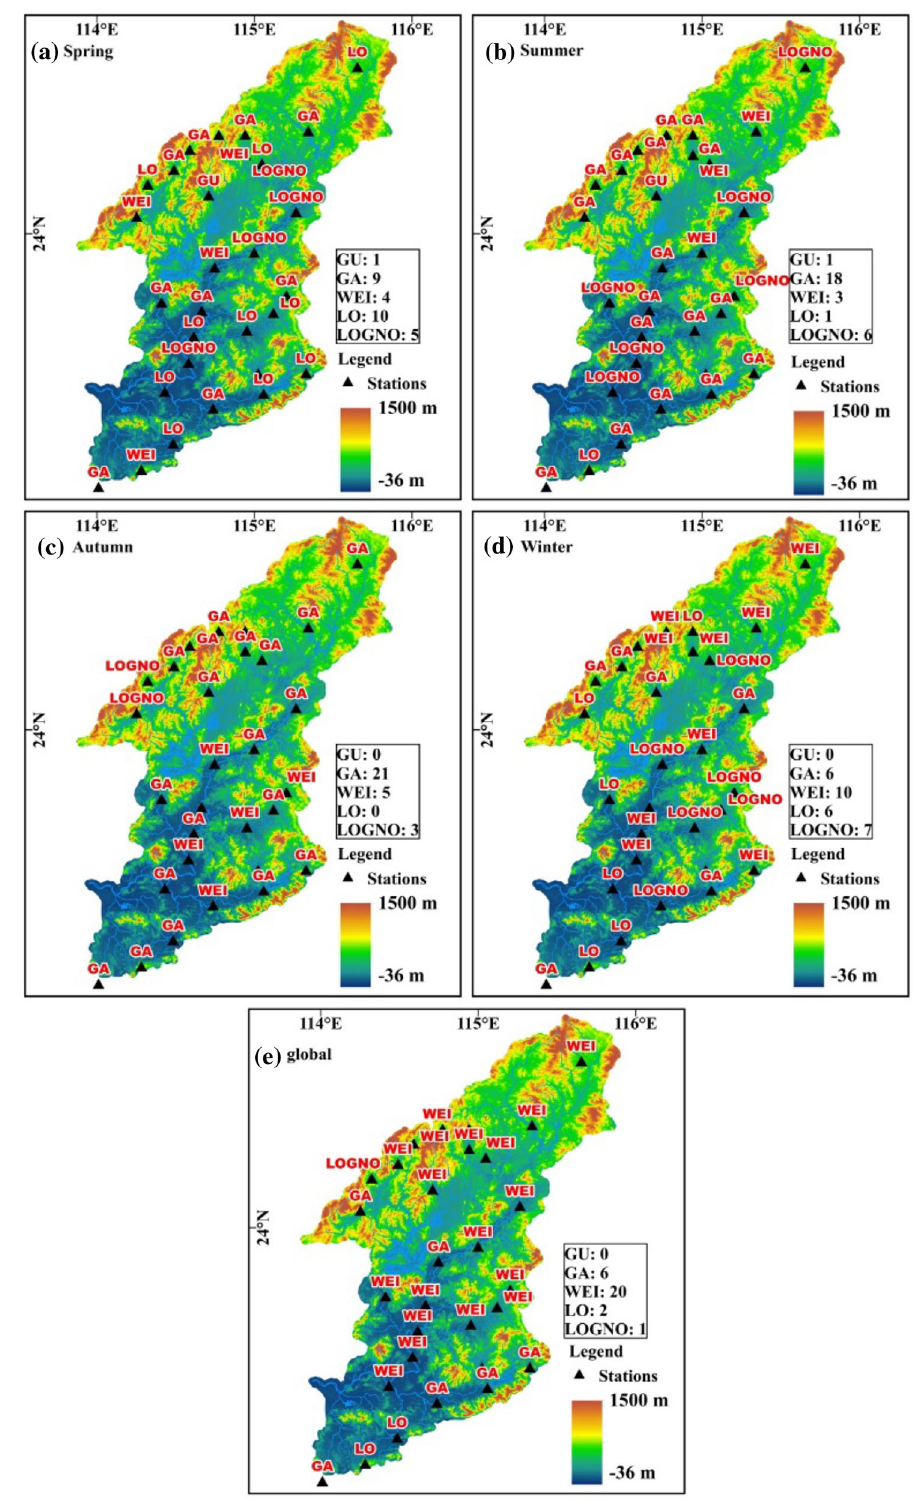
Fig. 2 Spatial distribution